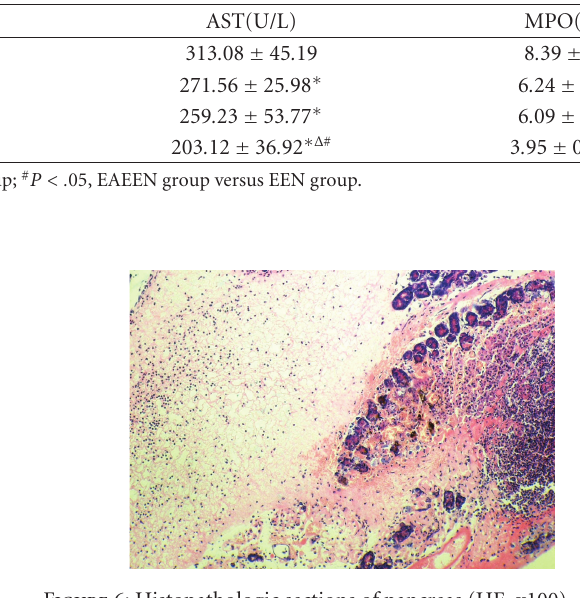
Figure 6: Histopathologic sections of pancreas (HE, x100), A: con- trol group. The pancreas of control group showed extensive necro- sis, di ff use edema, and massive inflammatory cells